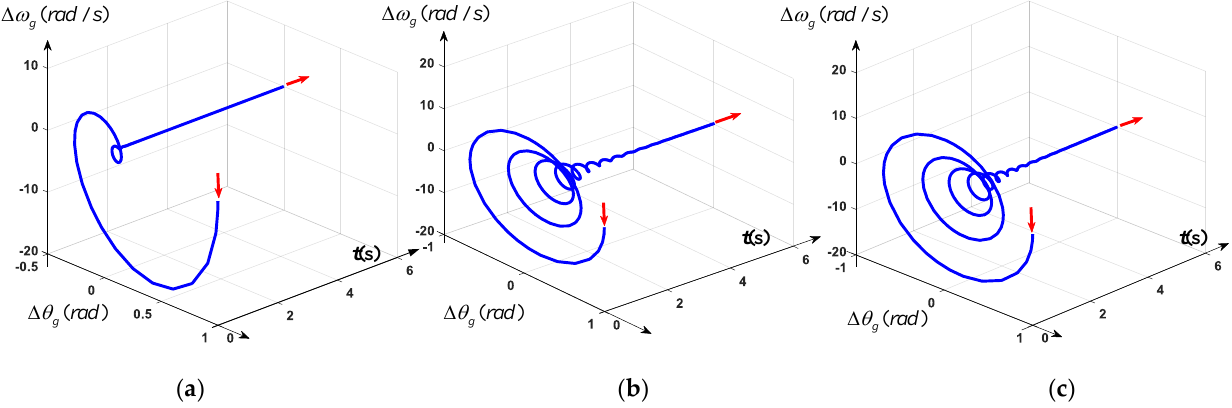
Figure 17. Internal voltage dynamics with different active output power: ( a ) P e = 0.6 p.u; ( b ) P e = 1.0 p.u; ( c ) P e = 2.0 p.u.